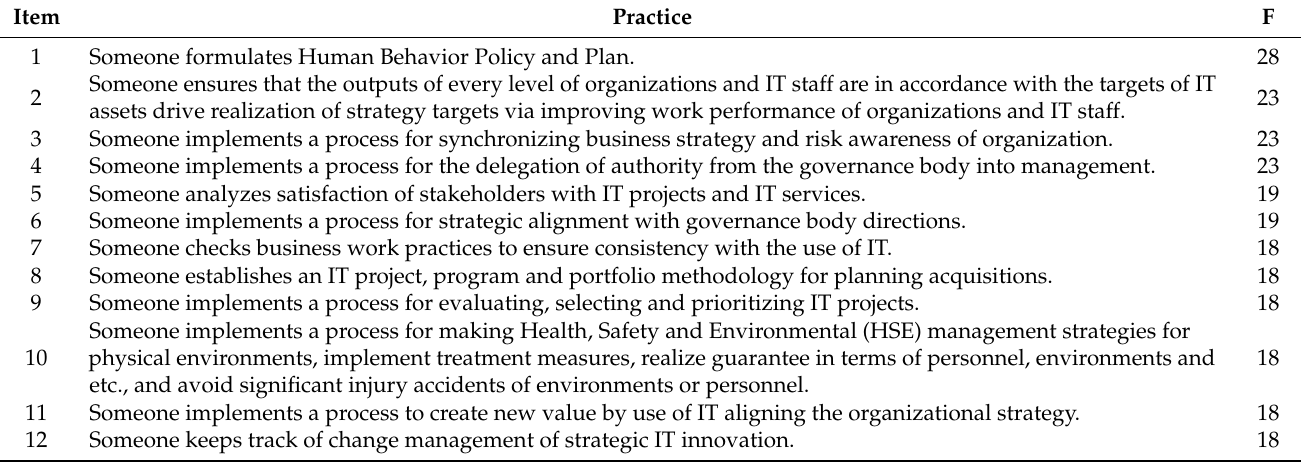
Table 3. List of best practices with higher frequency of MrM divergence (classifying them as gover- nance managerial